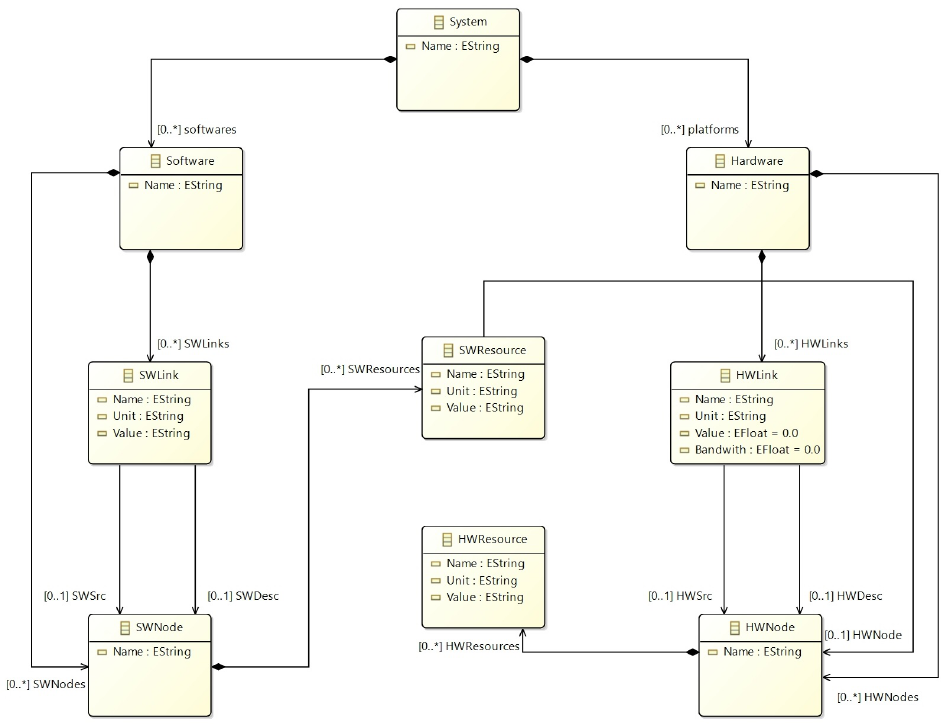
Figure 9. The SCALL meta-model.